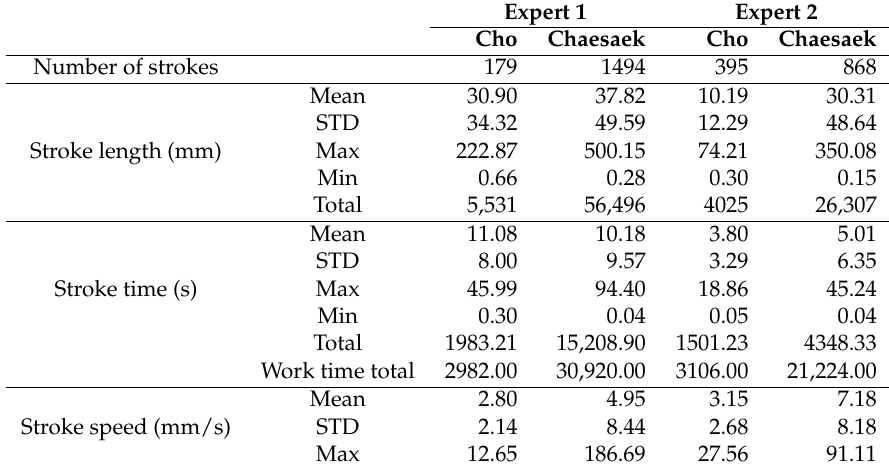
Figure 18. Visualization of stroke trajectories in each painting work, obtained by plotting the dots corresponding to the points of the strokes. The colors of the dots denote the progress of the drawing according to time. Black, red, and yellow indicate the early, middle, and final sections during painting, respectively. Table 1. Experimental results on strokes from two experts’ work. Cho and Chaesaek mean the sketching and coloring phases, respectively. Expert 1 Expert